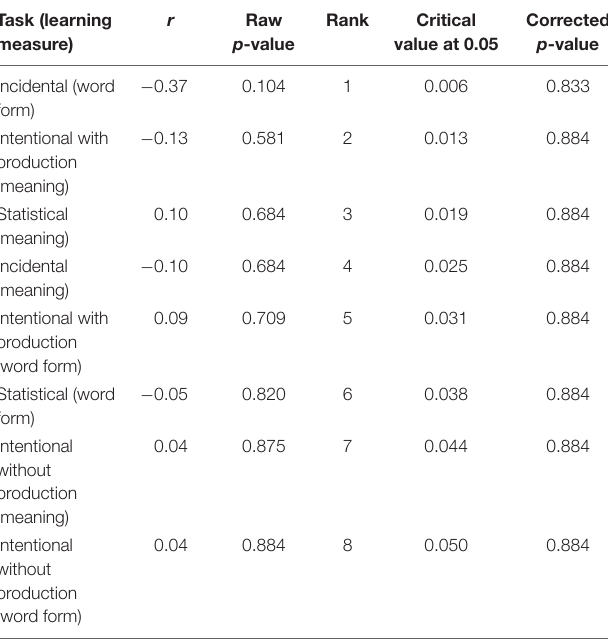
TABLE 8 | Correlations between the Memory for Names and learning performance with critical values of the Benjamini–Hochberg correction at an FDR of 0.05 and corrected p